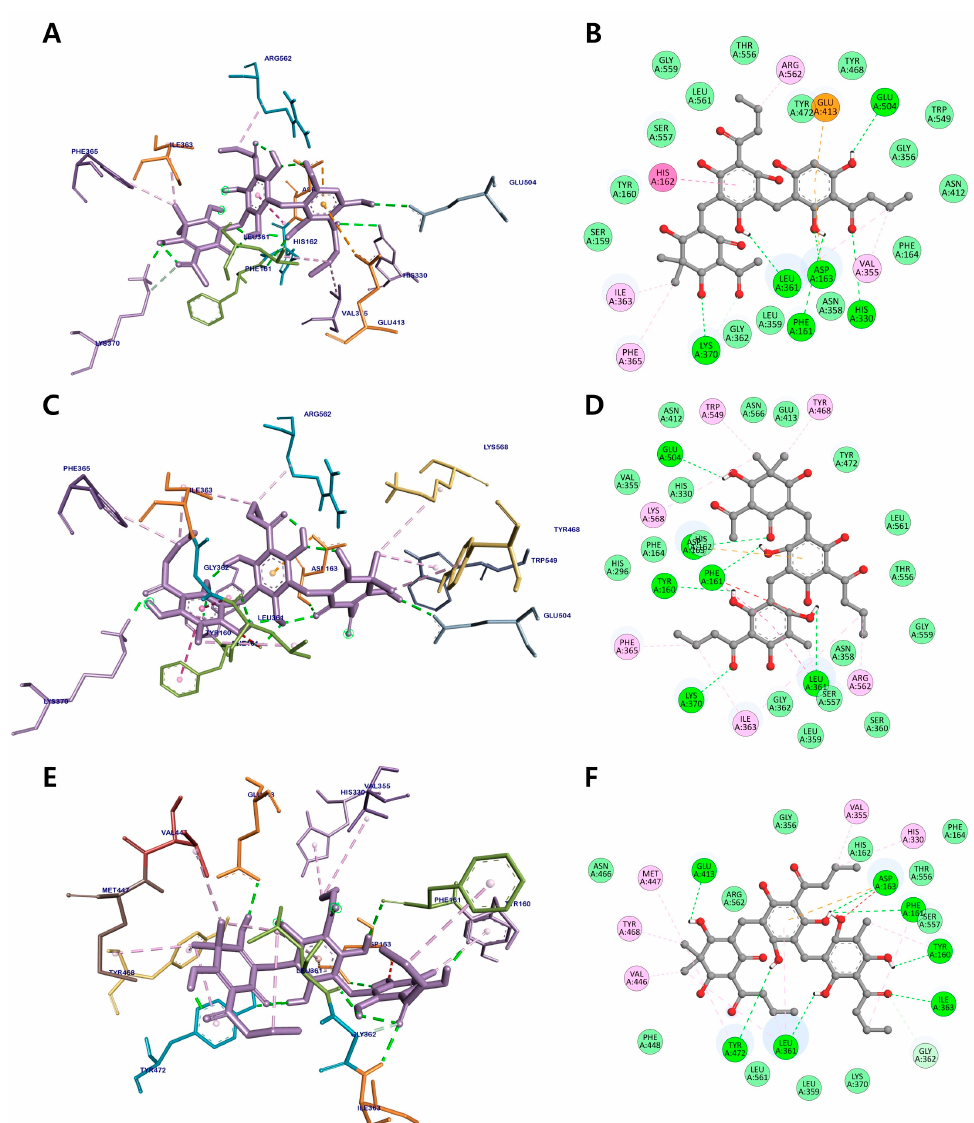
Figure 7. Three-dimensional molecular docking ( A , C , E ) and 2D interaction diagrams ( B , D , F ) of β -glucuronidase inhibition by trimeric phloroglucinols 26 – 28 , respectively.